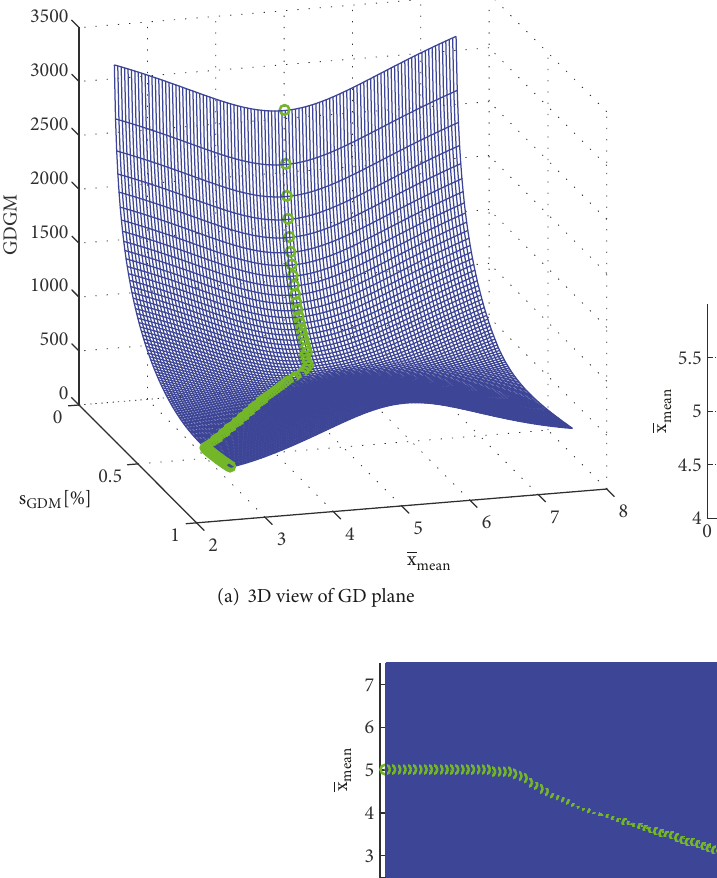
𝑥 plane GDGM mean